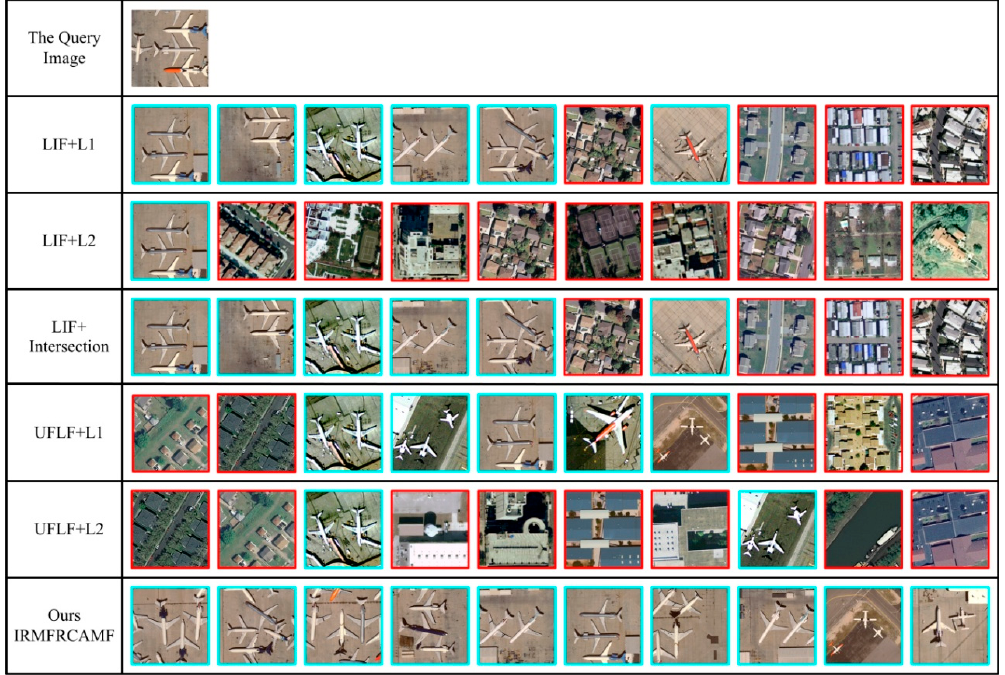
Figure 10. Visual illustration of the retrieved images using different methods when the query image comes from the airplane class. The red rectangles indicate incorrect retrieval results, and the blue rectangles indicate correct retrieval results.